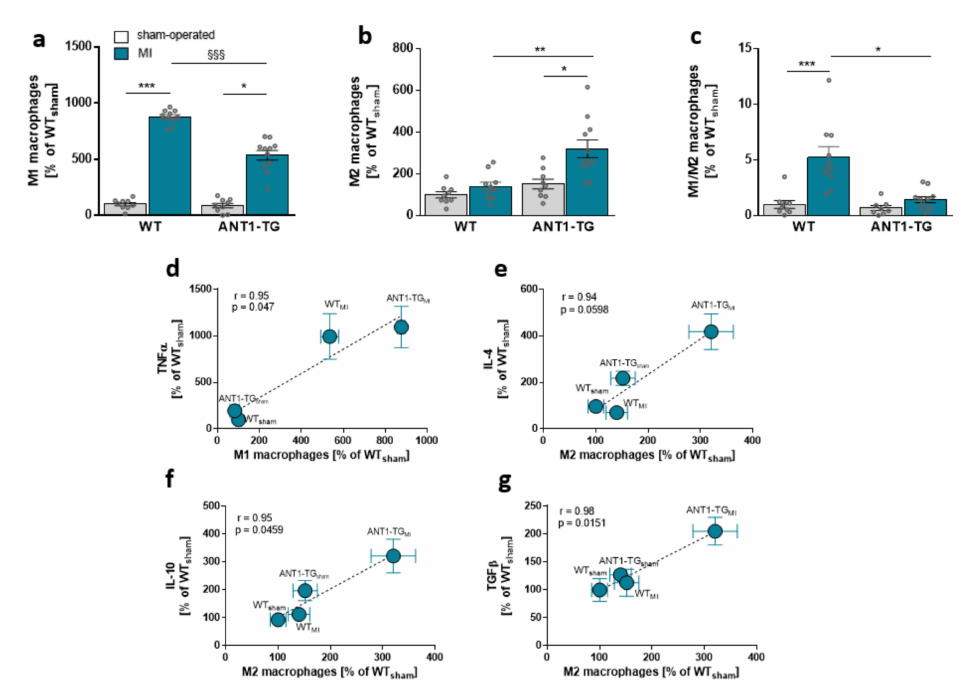
Figure 3. Myocardial macrophage levels and their relationships with immune modulator expression. ( a ) The percentages of M1-, ( b ) M2-specific macrophages, and ( c ) the M1/M2 macrophage ratio in sham-operated and infarcted (MI) hearts of WT and ANT1-TG rats. * p < 0.05, ** p ≤ 0.01, *** p ≤ 0.001 calculated with the Kruskal–Wallis test, using the Dunn’s test as post hoc test. §§§ p < 0.001 calculated with Mann–Whitney U test. The mean ± SEM of M1 macrophage levels found in the sham and infarcted hearts of WT and ANT1-TG rats positively correlated with the means of ( d ) TNF α . M2 macrophage levels were linked to ( e ) IL-4, ( f ) IL-10, and ( g ) TGF β . Correlation coefficients ( r ) and p -values are shown in the graphs. WT: wild-type; ANT1-TG: adenosine nucleotide translocase 1 transgenic rats; SEM: standard error of the mean; TNF α : tumor necrosis factor α ; IL: interleukin; TGF β : transforming growth factor β